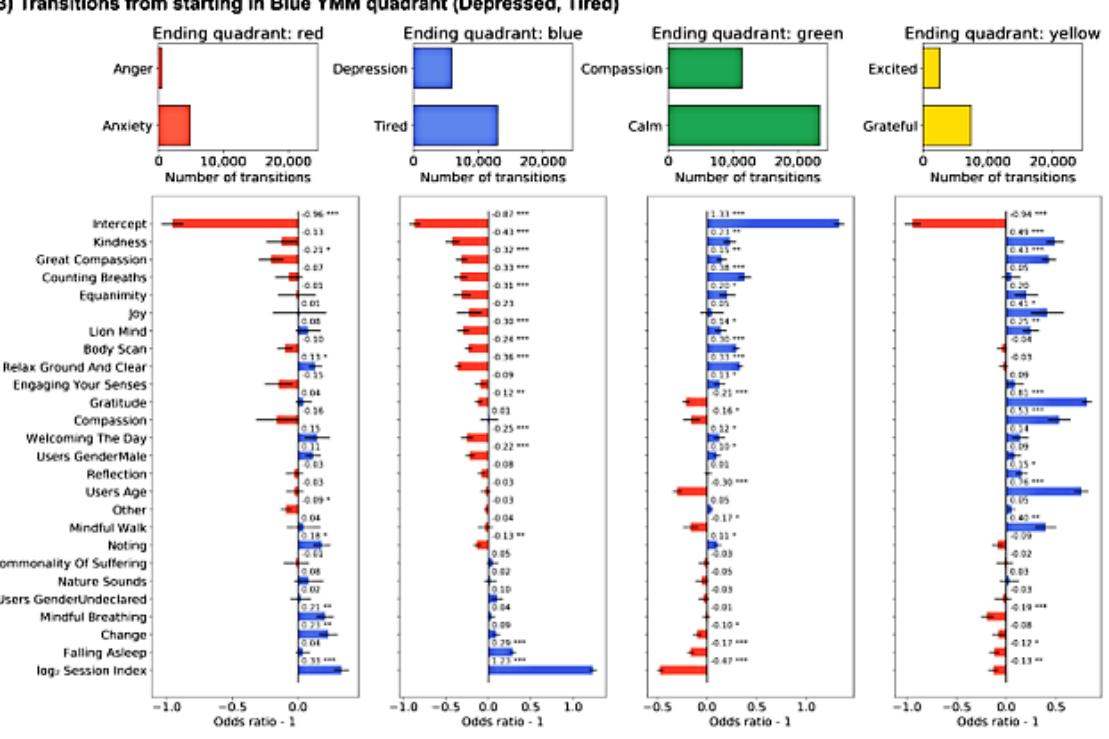
Figure 6. Transitions starting in Blue Yale Mood Meter (YMM) quadrant model odds ratios. Sixteen GLM model fixed effect estimated odd ratios and P values (<.001***, <.01**, and <.05*) for mindfulness and meditation activities, gender, session index, and y-intercept split by starting YMM quadrant. Blue bars indicate increased propensity to make a transition, whereas red bars indicate decreased probability of making the